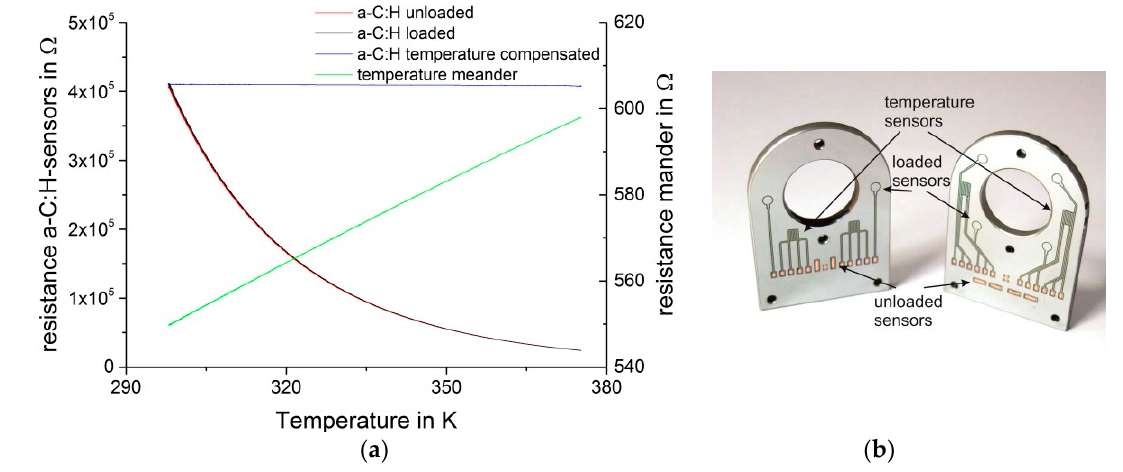
Figure 2. ( a ) Thermo-resistive characteristic curves of two force sensor structures, the compensated result and a temperature meander; ( b ) two different sensor layouts.